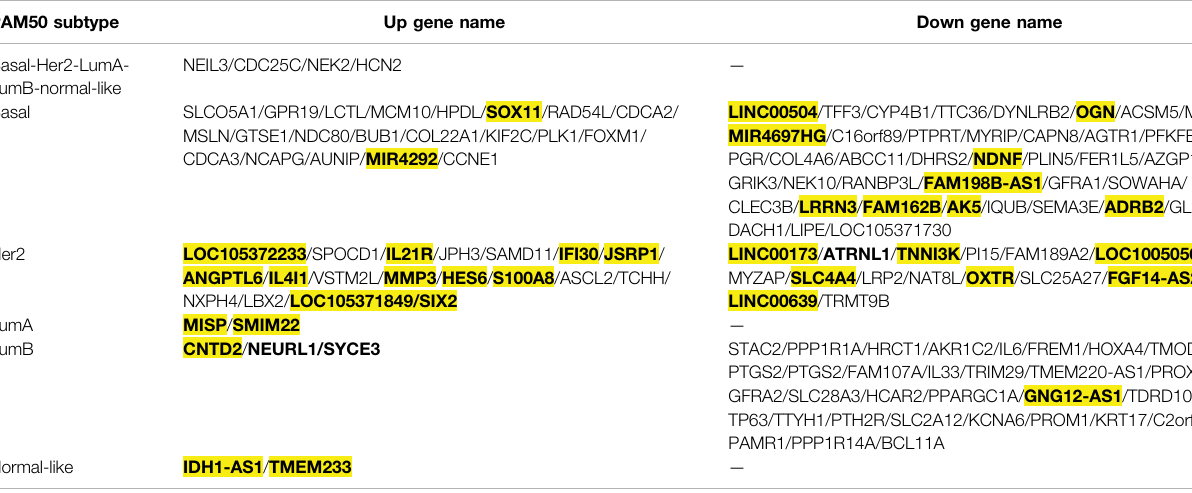
Supplementary Figure S5D ). In all breast cancer, low